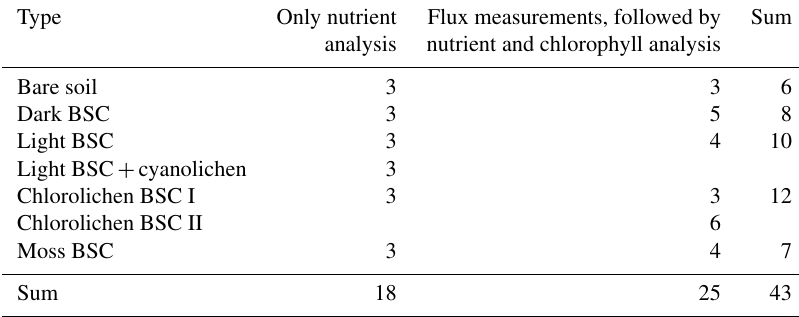
Table 1. Overview of the samples, distribution of replicates of soil–biocrust type and the different analyses. Type Only nutrient Flux measurements, followed by Sum analysis nutrient and chlorophyll analysis Bare soil 3 3 6 Dark BSC 3 5 8 Light BSC 3 4 10 Light BSC + cyanolichen 3 Chlorolichen BSC I 3 3 12 Chlorolichen BSC II 6 Moss BSC 3 4 7 Sum 18 25